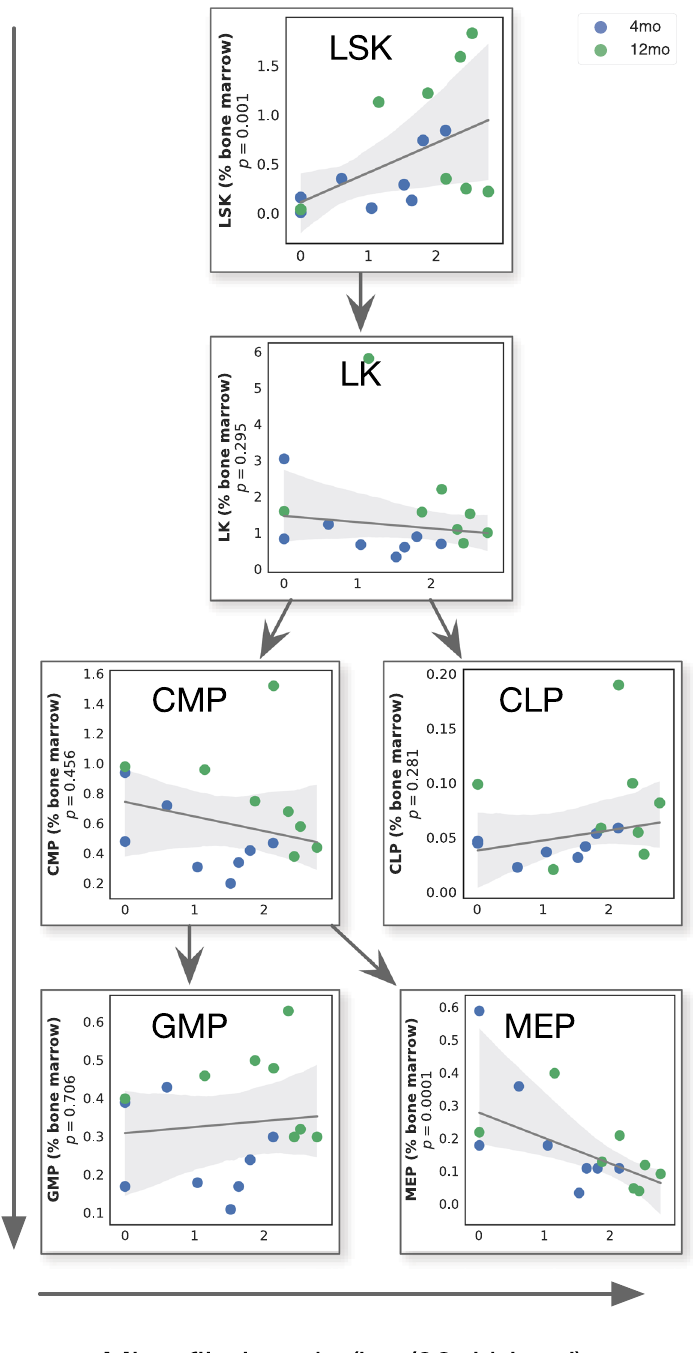
Figure 5. Association between worm burdens and HSPC proportions through haematopoietic development. Robust regression between microfilaraemia and percentage of HSPC in the bone marrow through haematopoietic maturation. Each point represents a single mouse (both ages combined) and the shaded areas represent the 95% bootstrapped confidence intervals around the robust regression line. P values from GLM of main effect of log-transformed microfilariae counts on the described cell type (n =